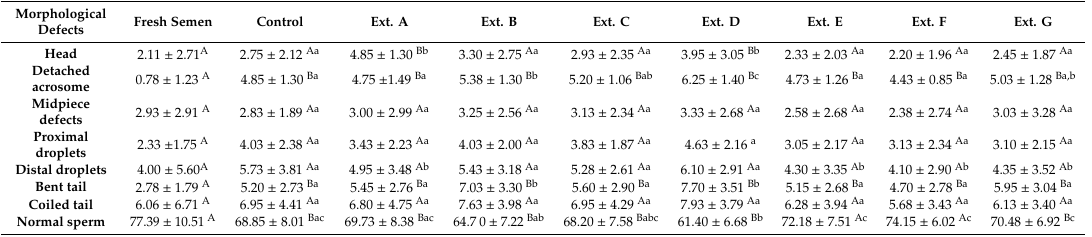
Table 2. Di ff erent types of morphological abnormalities in di ff erent extenders expressed as mean ± SD.